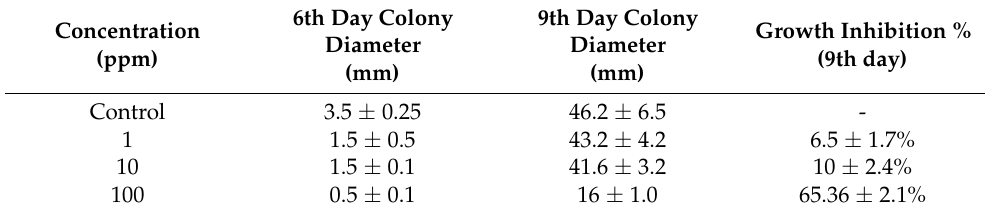
Figure 3. Effect of different concentrations of Ag NP on the growth of P. concavum at 9 days of age: control and treatments with Ag NPs of 0 (as control) 1, 10, and 100 ppm concentrations, agar dilution method.